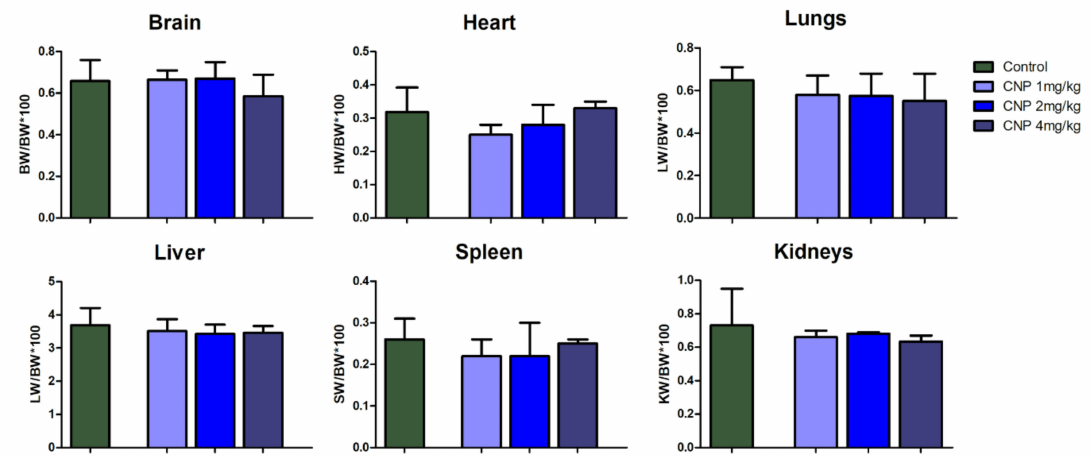
Figure 7. Mass ratios of rat organs 14 days after intravenous administration of CNP suspension. Median ± range. The ratio of organ mass to body weight is used in toxicology to detect target organs of the toxicant. There were no significant e ff ects of CNPs on mean weight ratios of the organs.